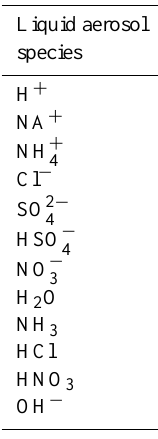
Table 2. List of the liquid aerosol species given by the ISORROPIA model.